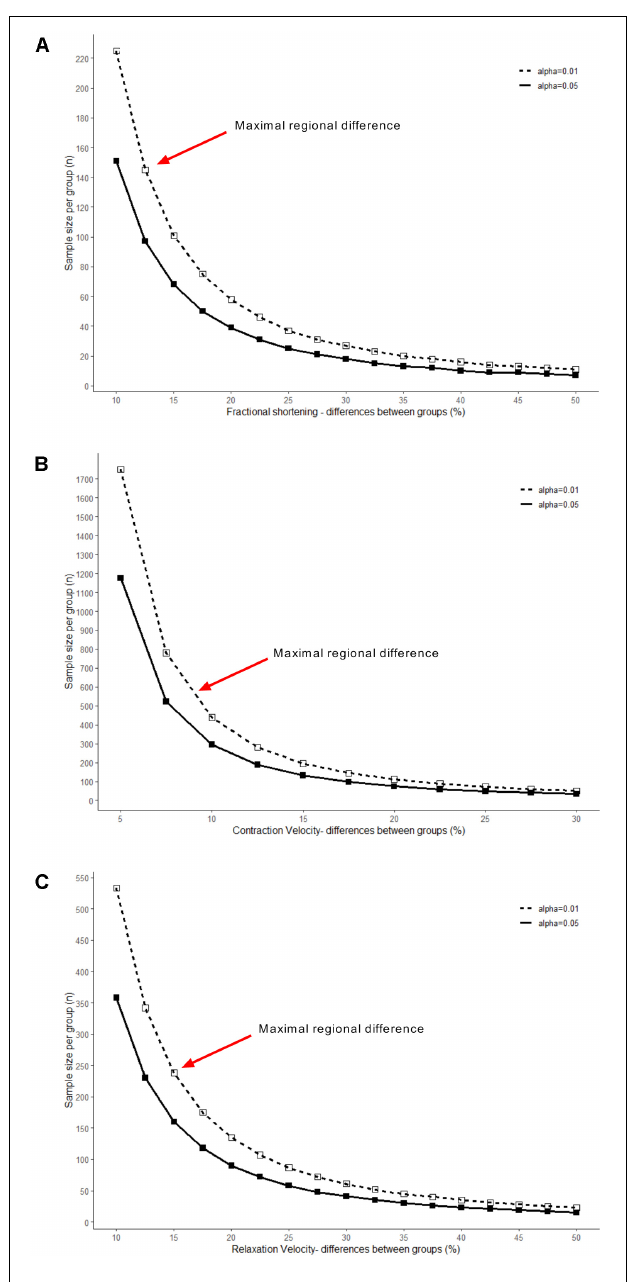
FIGURE 6 | Relationships between effect and sample size. Sample sizes needed to detect a range of effect sizes were calculated and plotted, using the variability of ventricular cells in: (A) fractional shortening, (B) contraction velocity, and (C) relaxation velocity. Solid line shows effect size at significance level of p < 0.05, dashed line of p < 0.01. Red arrows indicate sample size required for uncovering effect sizes at the magnitude of the regional differences identified in this